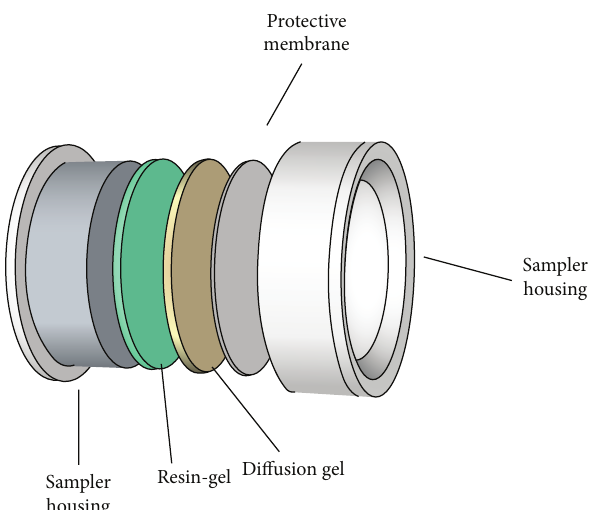
Figure 1: A schematic render of a DGT passive sampler showing its principal